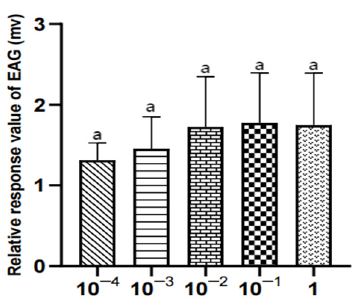
Figure 22. EAG responses of female W. magnifica to different concentrations of 1-octen-3-ol.